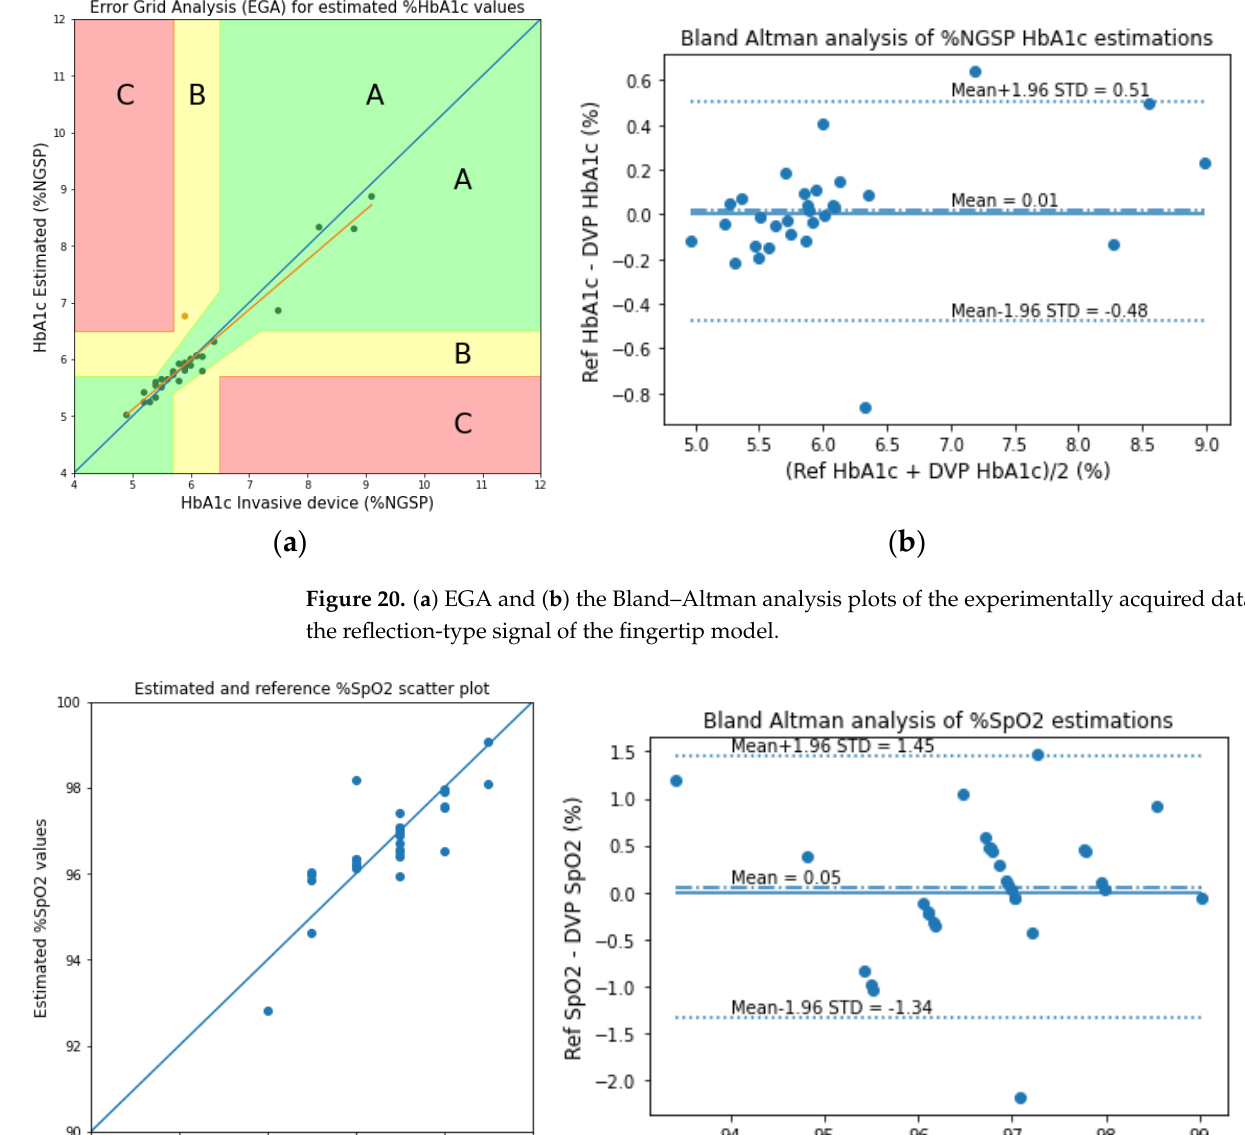
Figure 21. ( a ) Scatter plot for the reference and estimated SpO 2 values and ( b ) the Bland – Altman